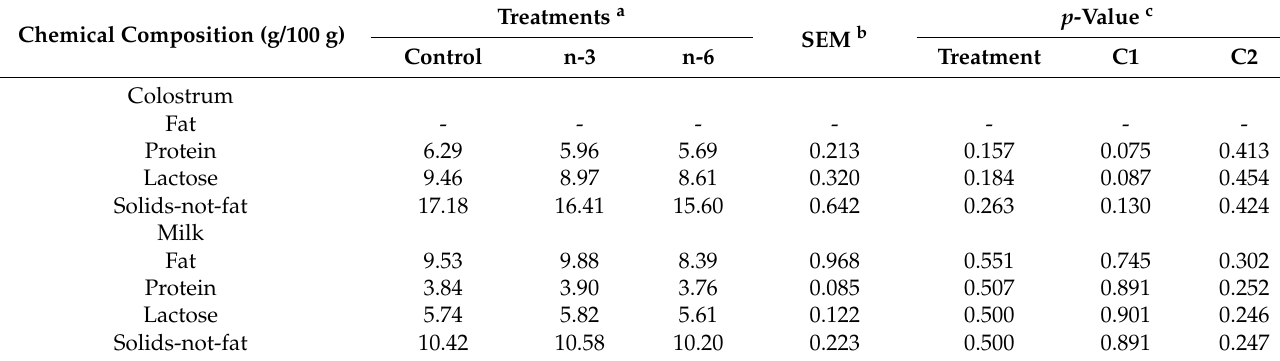
Table 6. Effects of enriched milk supplementation on colostrum composition of lactating